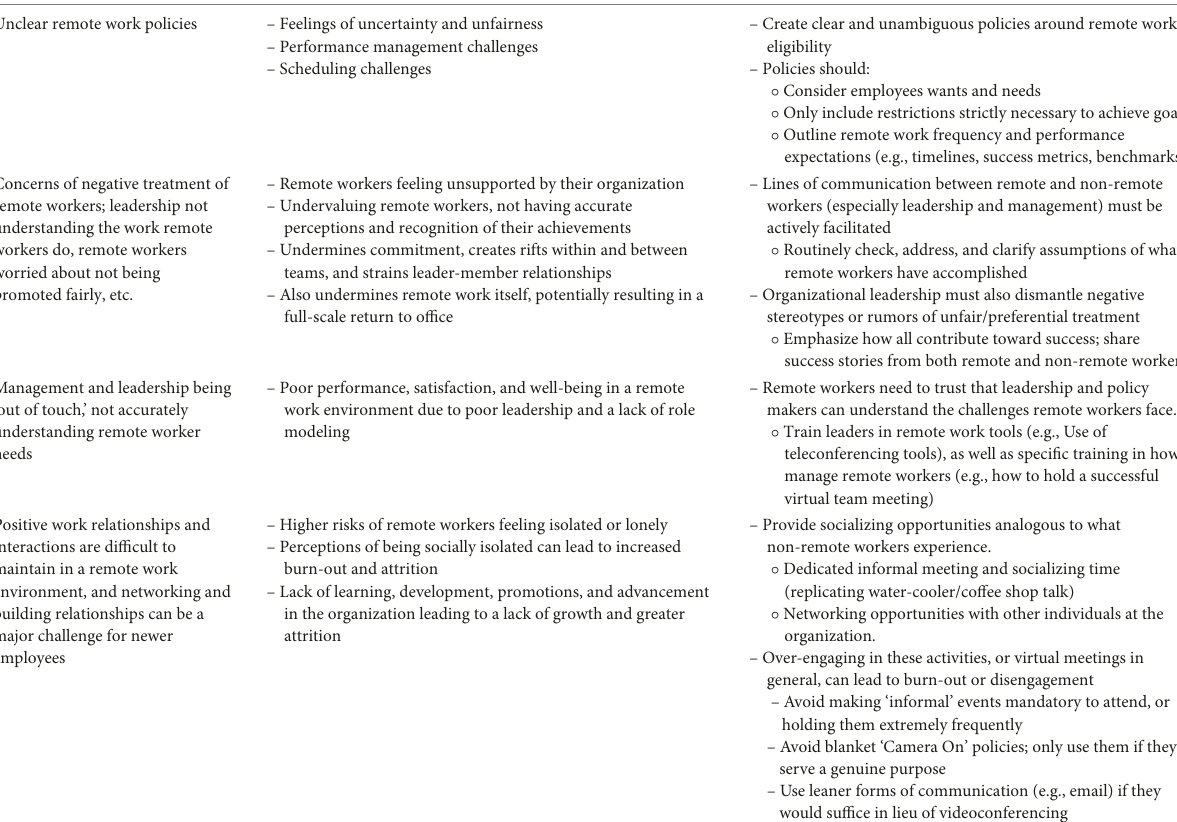
TABLE 3 Table of